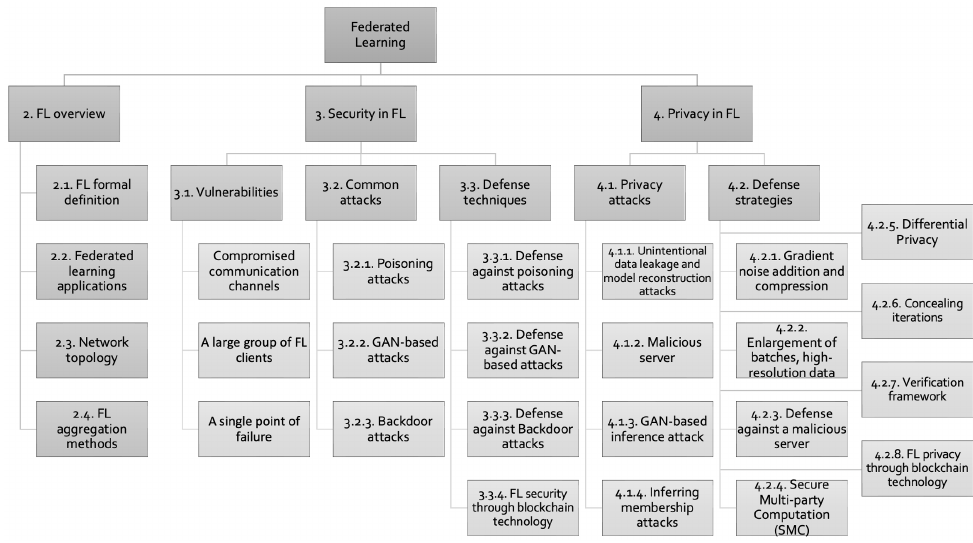
Figure 2. Taxonomy of security and privacy studies in FL. We report the sections of the paper that discuss each of the mentioned